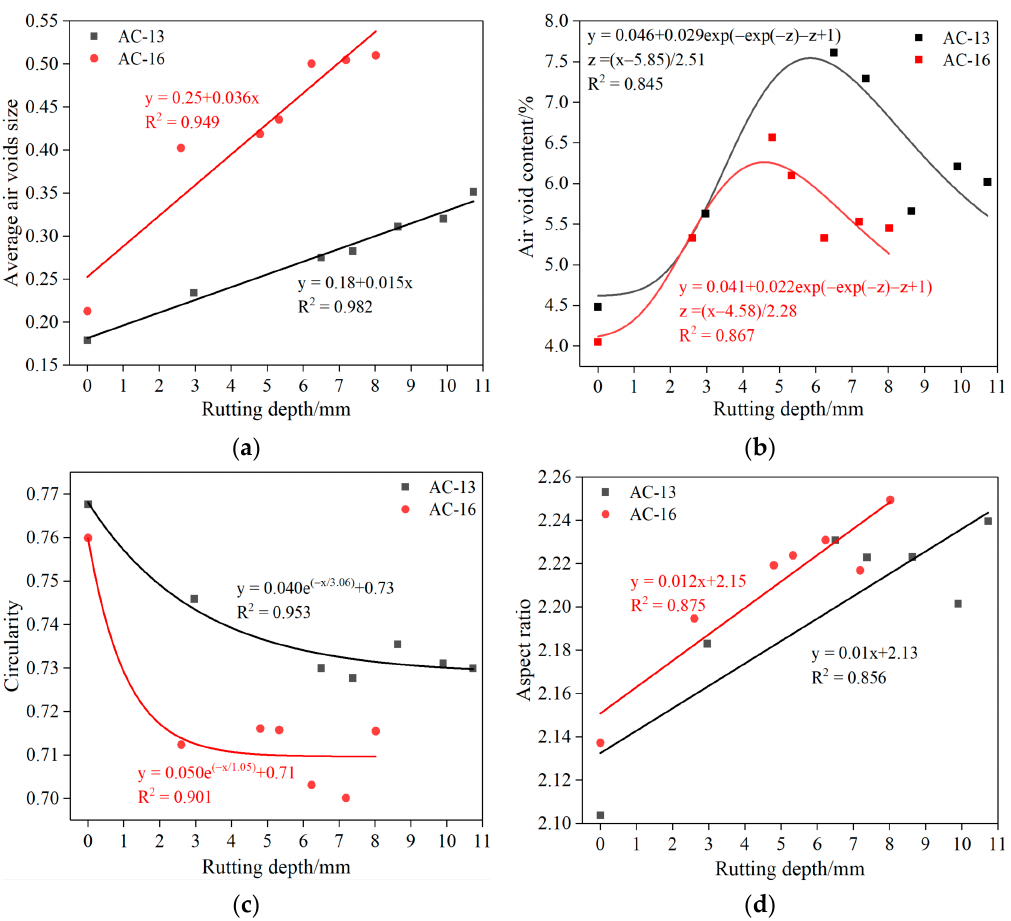
Figure 9. Correlation between rutting depth and air-void distribution: ( a ) average air-void size; ( b ) air-void content; ( c ) circularity; ( d ) aspect ratio.